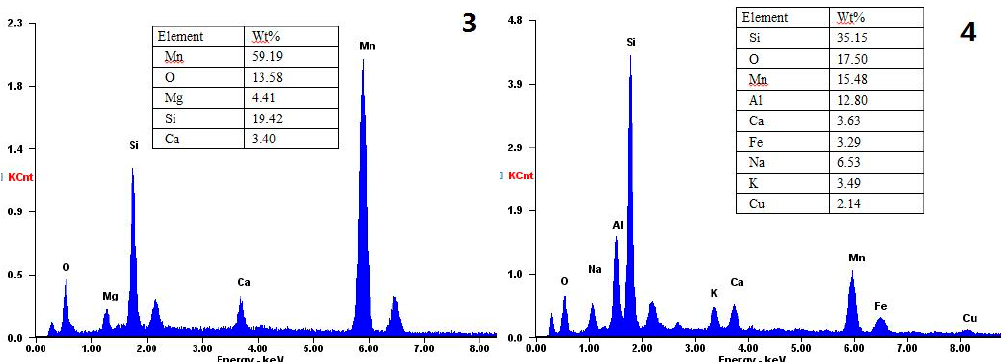
Figure 13. SEM image and energy spectrum of the reduction calcines at 1100 °C.